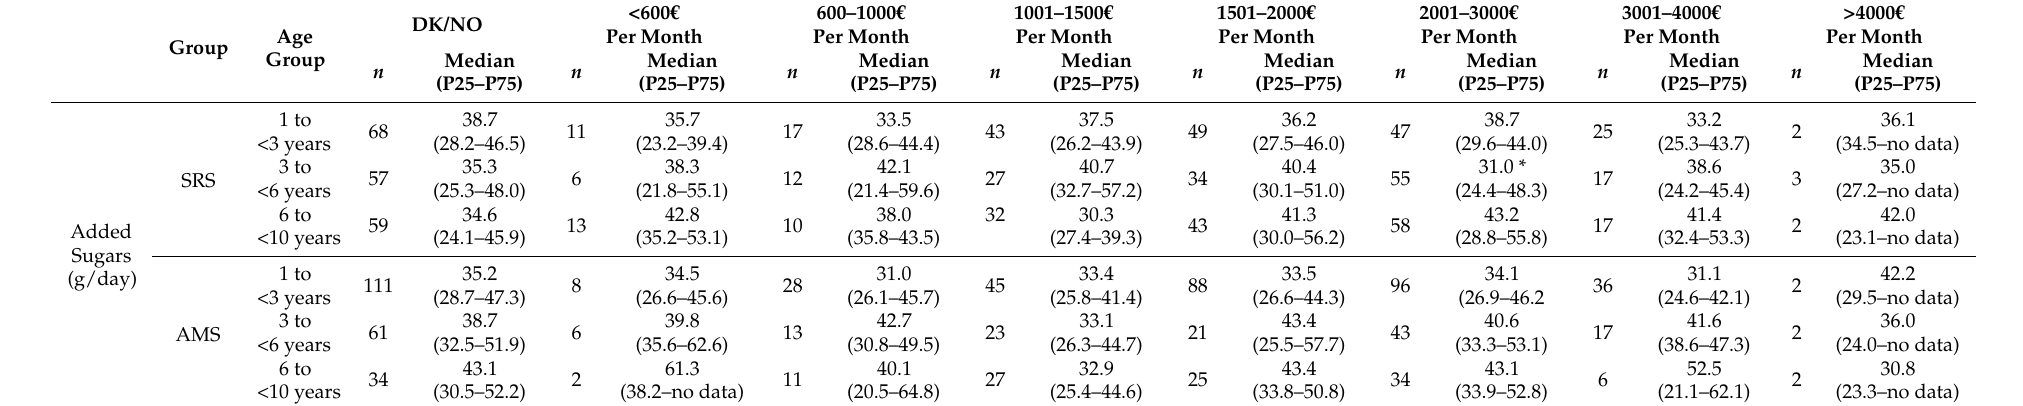
Table 6. Usual added sugar intakes by income level and age groups from the Spanish Pediatric Population (EsNuPI)